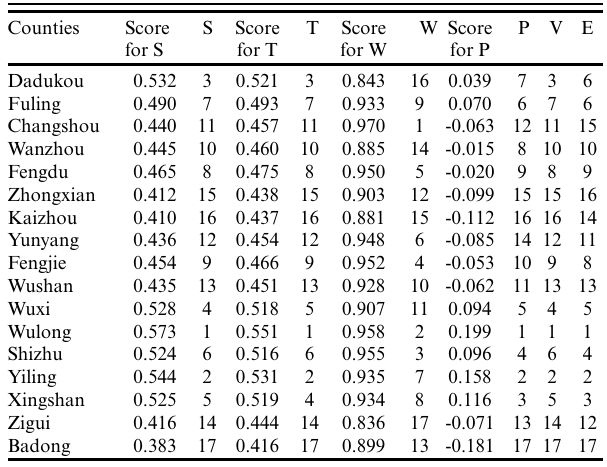
Table 4 . Disaster resilience ranking calculated using the average weight